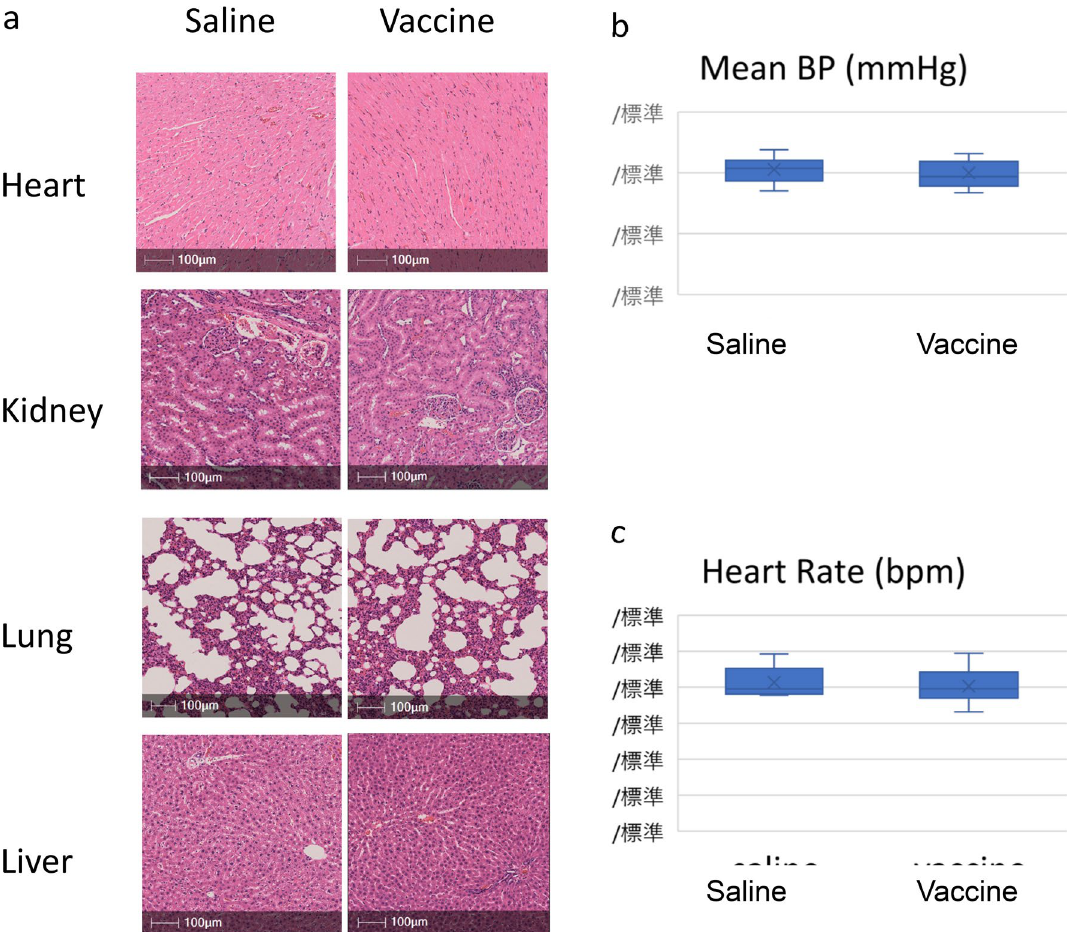
Figure 6. sEH vaccine was safely administrated in rats. ( a ) A representative photomicrograph of hematoxylin and eosin staining in heart, lung, kidney, and liver. Scale bars = 100 μm. ( b ) The mean blood pressure at 11 weeks of age before MI induction. Saline group (n = 10), vaccine group (n = 11). ( c ) The mean heart rates at 11 weeks of age before MI induction. Saline group (n = 10), vaccine group (n =